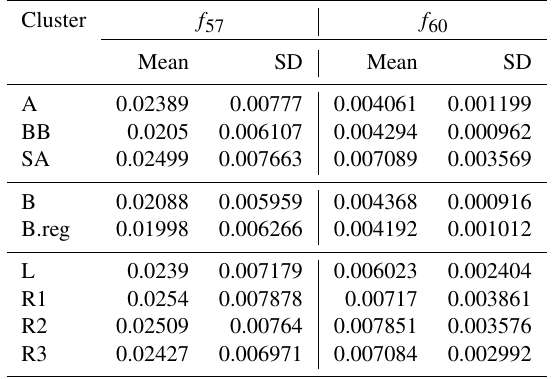
Figure 2. Mean values of (a–c) NRPM 1 ; (d–f) organics, inorganics, and BC; and (g–i) PM 1 species (from top to bottom) for the various air masses. Panels (a) , (d) , and (g) are for AS, BB, and SA; (b) , (e) , and (h) are for BB branches (B and B.reg); and (c) , (f) , and (i) are for SA branches (L, R1, R2, and R3). Table 2. Cluster means of f 57 and f 60 values for all branches, where SD means standard